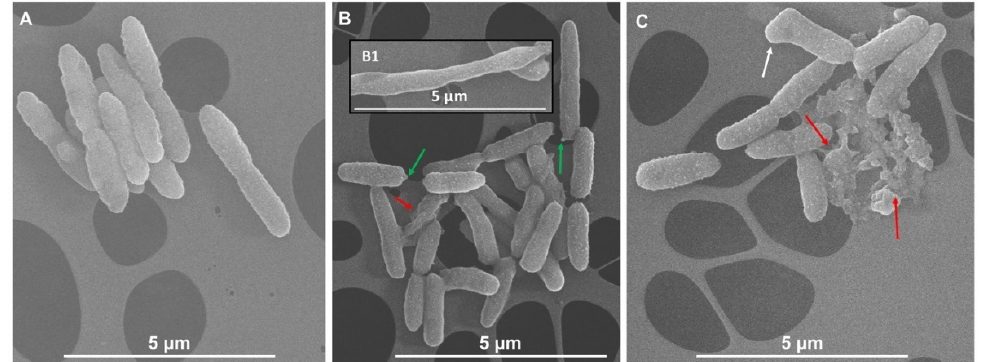
Figure 5. Scanning electron micrographs of unchallenged ( A ) or challenged P. aeruginosa cells with lemon ( B ) and/or grapefruit ( C ) IntegroPectins. The inlet B1 shows an elongated and undivided cell. Nonorthodox cell morphology is indicated by white arrow; cell death events are underlined by red arrows, while green arrows highlight the presence of blebs of the cell envelope.